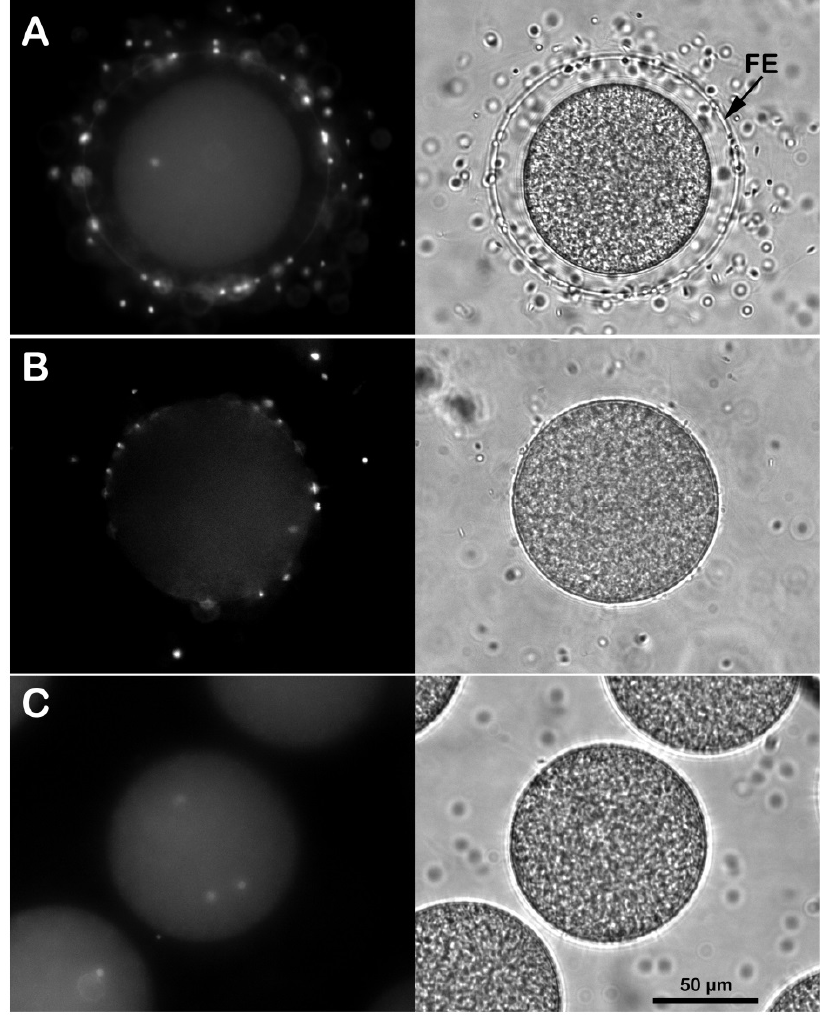
Figure 3. Effect of the removal of the egg jelly and vitelline layers on the sperm entry. ( A ) Intact P. lividus eggs inseminated in NSW with DNA-stained sperm were all penetrated by a single one, as shown by the UV laser in epifluorescence microscopy 5 min after insemination. The FE was fully elevated around the zygote, as shown in the transmitted light image. Monospermic fertilization or inhibition of sperm entry was observed in P. lividus eggs incubated for 5 min in acidic sea water and fertilized in the same medium ( B ). Note that at variance with the control in A, it was difficult to visualize the elevation of the FE in the eggs fertilized in acidic seawater due to its attachment to some regions of the egg surface, as shown in the EM image in Figure 2F. Multiple sperm incorporation was observed when the P. lividus eggs were pre-treated with 10 mM of DTT at pH 9 for 20 min to remove the egg’s layers and then fertilized in NSW ( C ).